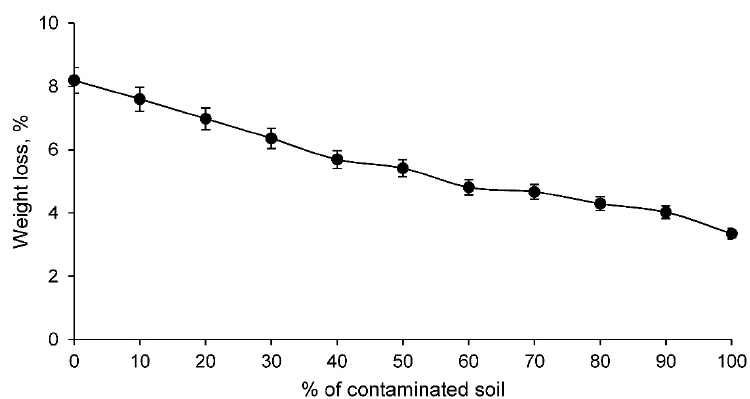
Figure 4. Weight loss of conforming ceramics families with various percentages of clay and contami- nated soil.